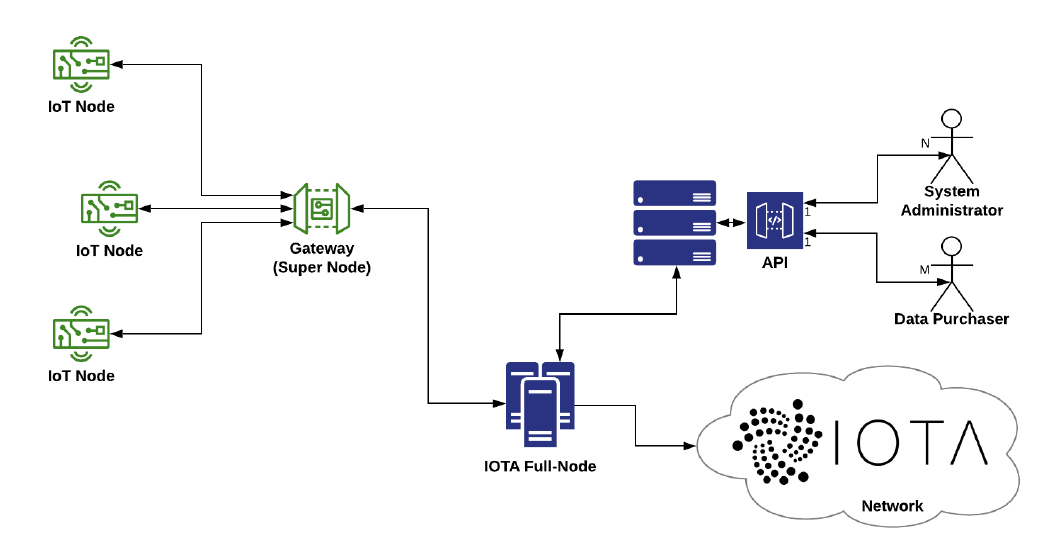
Figure 1. High Level